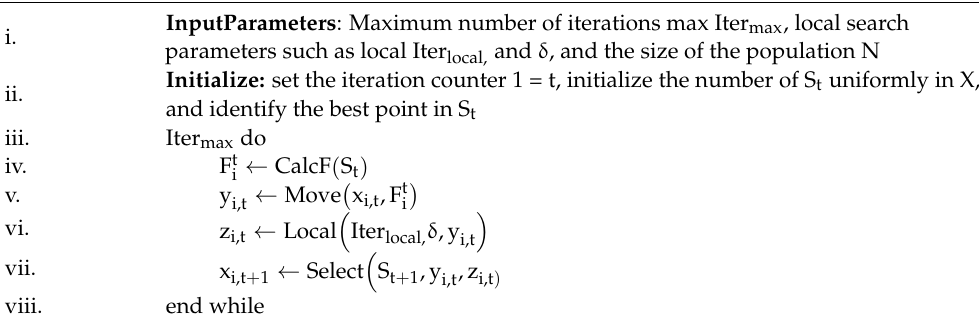
Algorithm 1: A summary of the EMO algorithm is given